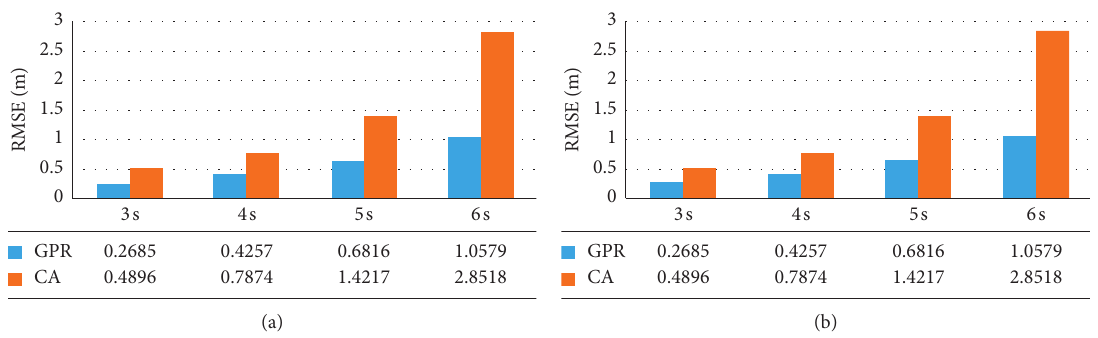
Figure 8: The trajectory prediction error of straight vehicle and left-turn vehicle. (a) Straight vehicle. (b) Left-turn vehicle.